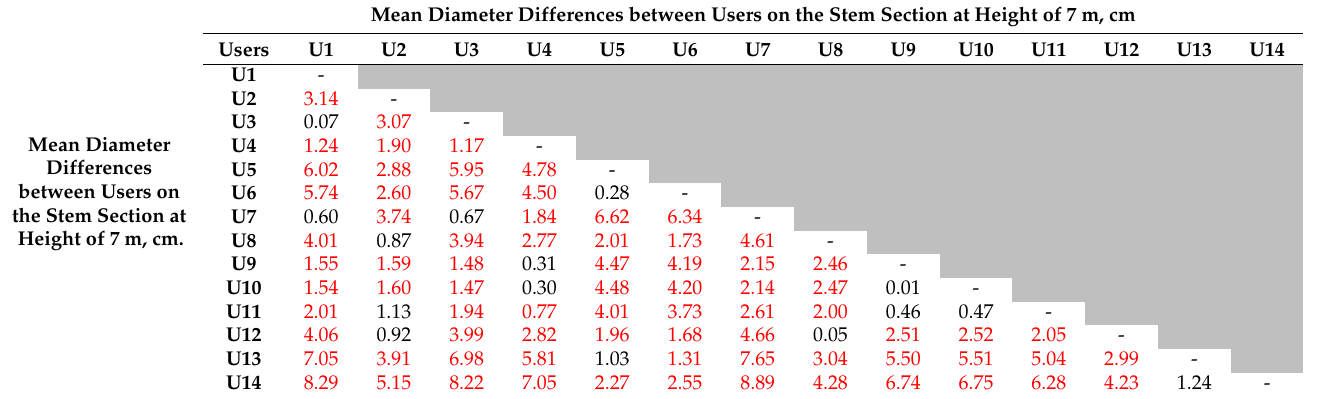
Table A4. Differences between mean diameters obtained by each user when a laser caliper was used to measure upper-stem diameters at a height of 7 m. The red values denote significant differences between the mean diameters obtained by the